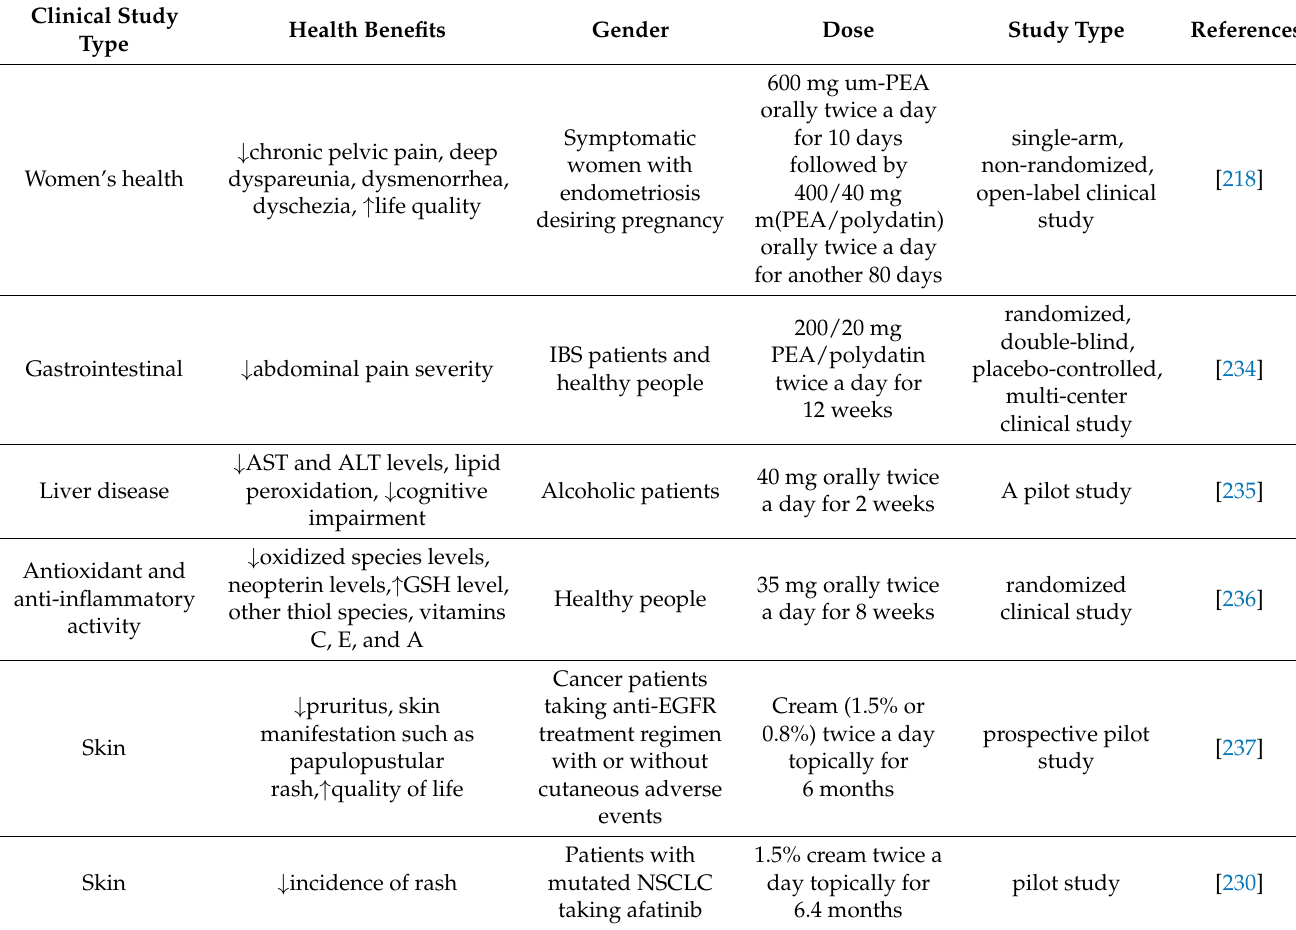
Table 10. Clinical trials on